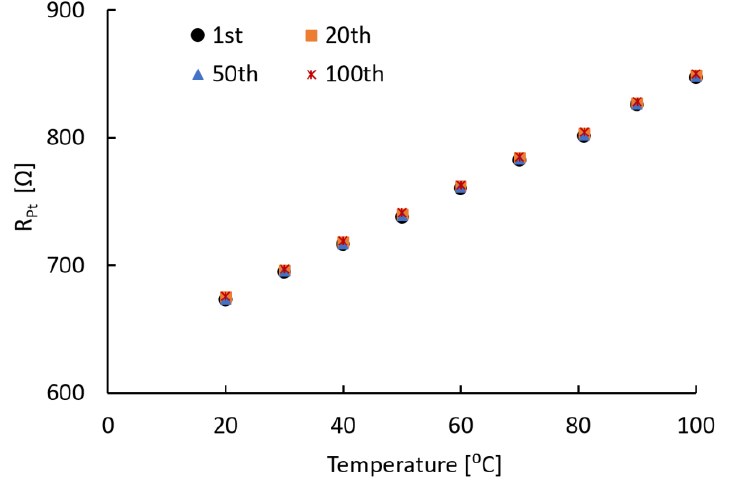
Figure 6. Resistance of Pt resistor for 100 sweeps of the temperature between 20 and 100 °C.